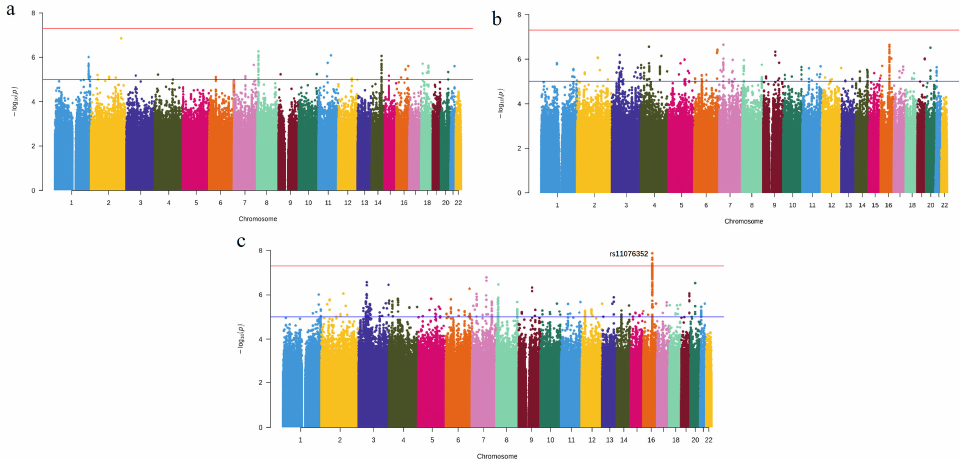
Figure 1. Manhattan plot of − log10 ( p ‐ values) of the GWAS results. ( a ) Summary statistics from the GLIDE consortium. ( b ) Summary statistics from FinnGen. ( c ) Meta ‐ analysis results. The red and blue horizontal lines indicate the level of genome ‐ wide significance ( p = 5.0 × 10 − 8 ) and nominal significance ( p = 1.0 × 10 − 5 ), respectively. GWAS, genome ‐ wide association study.